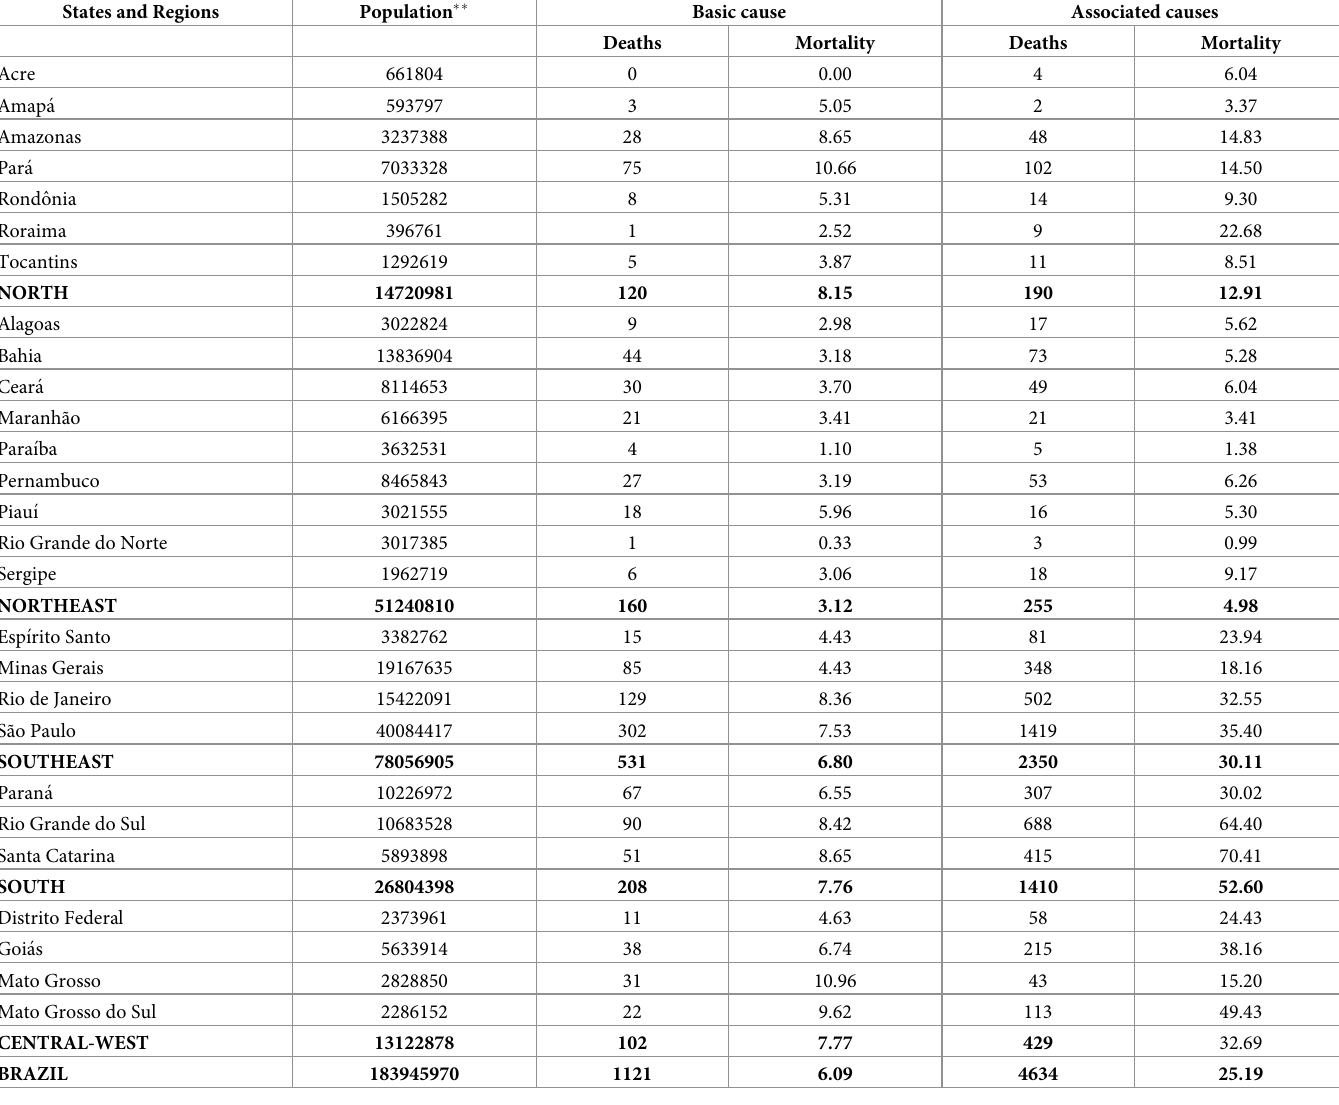
Table 5. Deaths and mortality rates � by cryptococcosis, for basic and associated causes, by Regions. Brazil, 2000 to 2012. States and